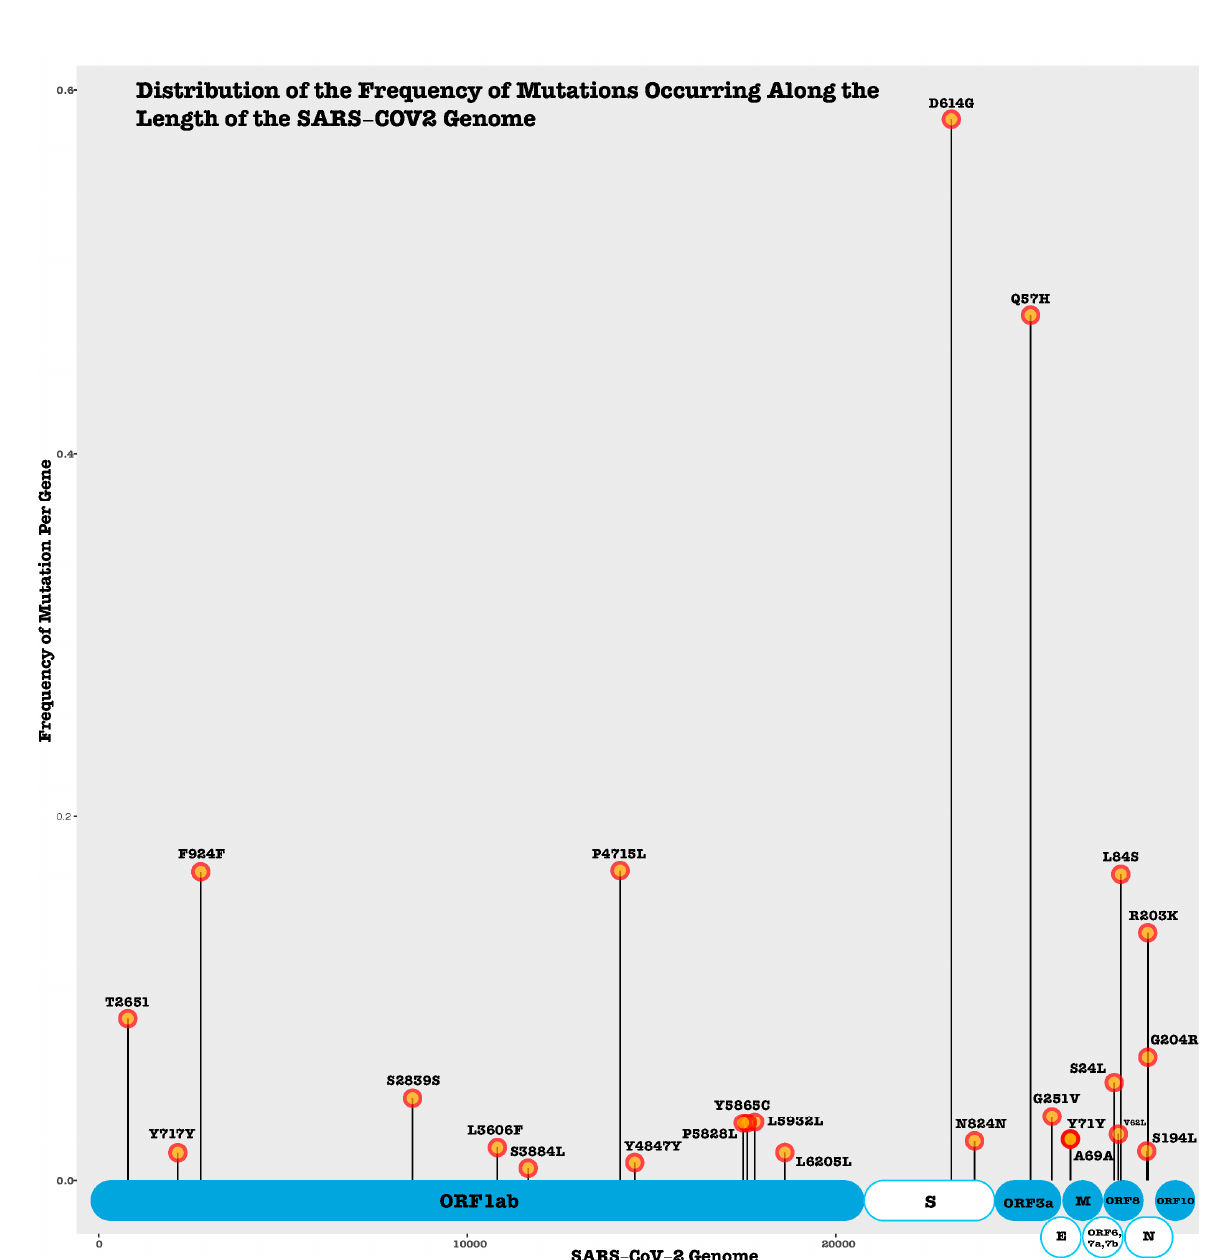
Figure 2. Mutations (synonymous, non-synonymous, deletion, and insertion) occurring across the SARS-CoV-2 genome. Only modifications that appear over 100 times in the dataset are in the figure. The frequency of each mutation by gene was calculated and displayed in the plot. Data for the plot can be found in the Supplementary Material of this publication. Genomic modifications and changes in the protein secondary structure and solvent accessibility of SARS-CoV-2 (COVID-19 virus) [144] .